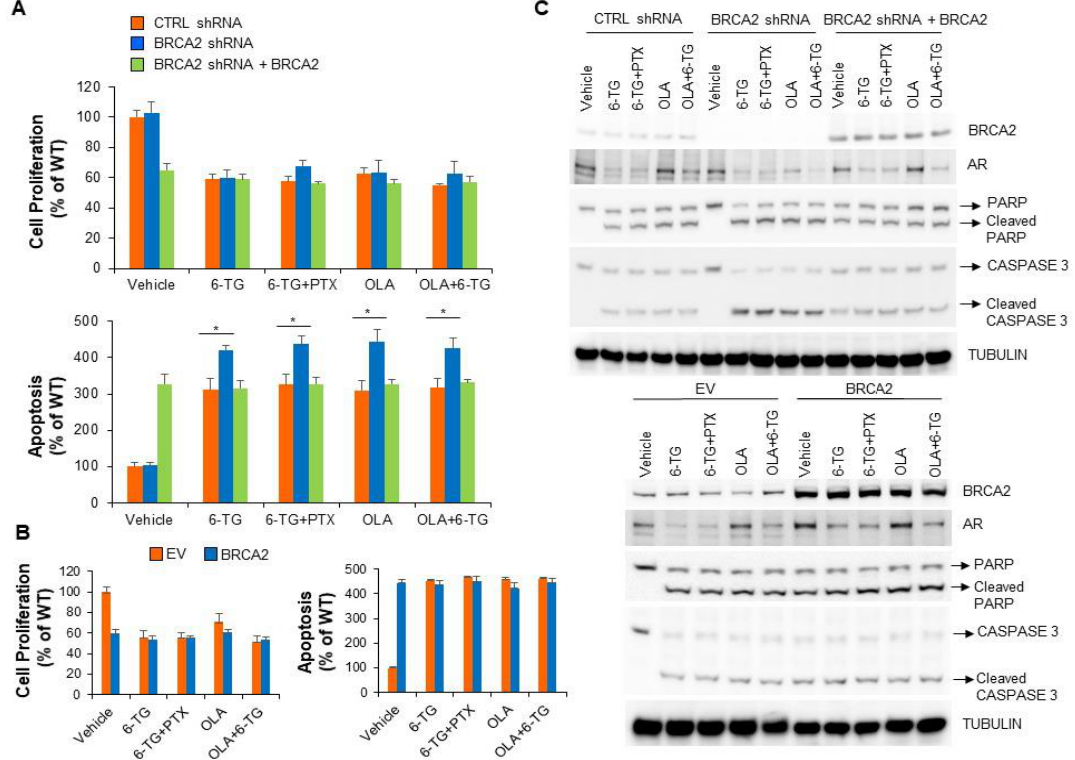
Figure 6. 6-TG-induced apoptotic response in prostate cancer cells is similar in extent to the apoptotic effect induced by olaparib. ( A , B ) DU145 cells expressing doxycycline-inducible BRCA2 shRNAs or non-targeting shRNAs (WT) were treated with doxycycline ( A ). Thirty-six hours after doxycycline treatment, cells were added with solvent alone (Vehicle), 6-TG (5 µM), paclitaxel (10 nM) or a combination of the two drugs, and with olaparib (5 µM; OLA) or a combination of olaparib (5 µM; OLA) and 6-TG (5 µM). Where indicated, 24 h after doxycycline treatment and before addition of the drug / s, BRCA2 cDNA was transiently transfected in BRCA2 shRNA-expressing cells (BRCA2 shRNA + BRCA2). In B , DU145 cells were transiently transfected with BRCA2 cDNA or empty vector (EV) and added with the drugs 48 h after transfection. Forty-eight hours after drug treatment, cell proliferation and apoptosis were measured by XTT and Cell Death Detection assay ( A , B ) or the cells were lysed and total protein extracts analyzed by immunoblotting as indicated ( C ). In the graphs, each point represents the mean ± SD from cells of triplicate wells. The experiment was repeated two times. * p < 0.001.